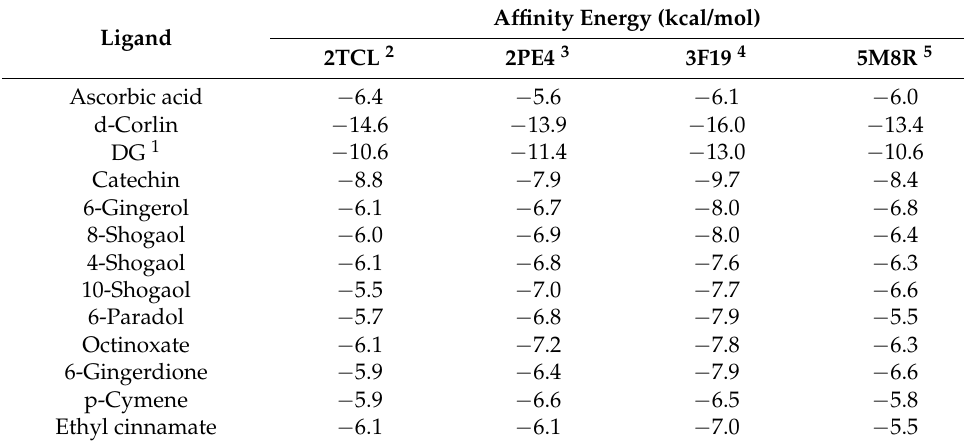
Table 2. The affinity energy of the ligand–receptor